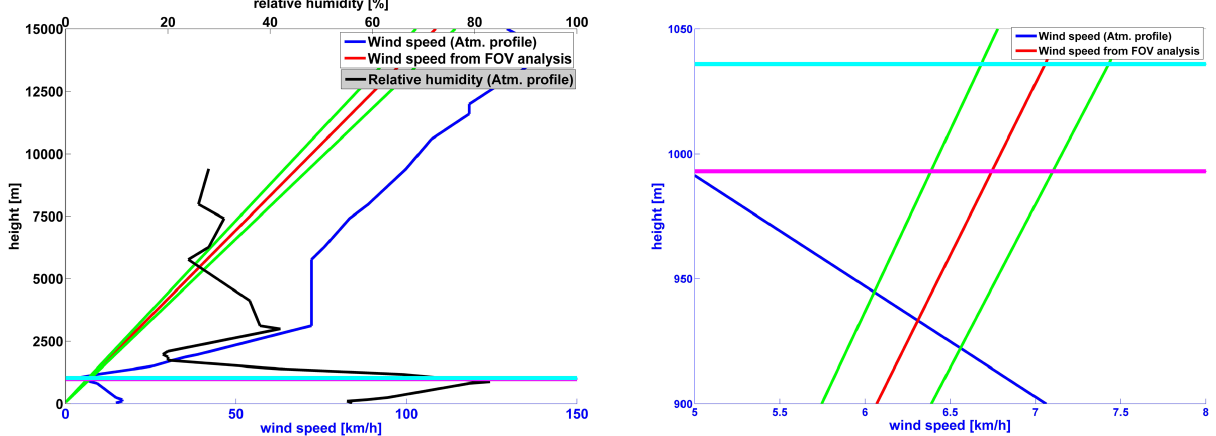
Fig. 7. Intersecting theoretical possible wind speed profile derived from FOV (field of view) analysis (red line wrapped with green error limits), with wind speed profile measured by a radiosonde in a nearby station at Beit-Dagan (blue line). The heights at which these two lines intersect mark the possible heights of the clouds layer. Left: profile range 0–15km. Right: zooming on 900–1050m. The black line is the relative humidity profile (notice how the intersection point at 934m corresponds to a sharp increase in the RH). the magenta line is the LCL height (993m) as derived by the radiosonde data (Bolton, 1980). The cyan line is the cloud base height (1036m) extracted by a nearby ceilometer (Website: “Station Observations”).